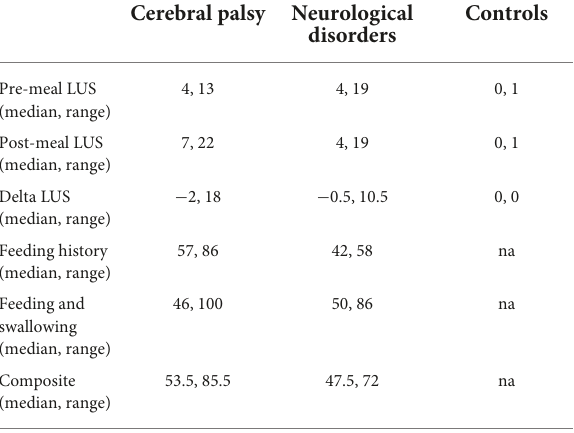
TABLE 2 Lung ultrasound and clinical